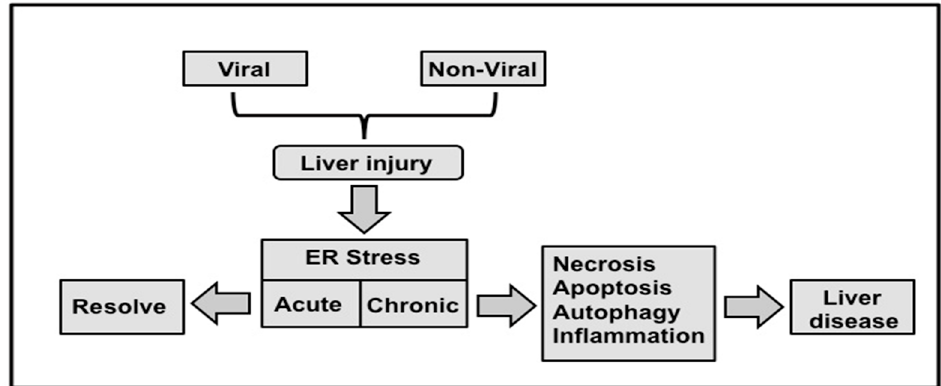
Figure 8. Diagram showing the relationship among ER ‐ stress, autophagy, and inflammation in the progression of liver disease induced by HCV infection. The ER ‐ stress can be tolerated from days to years through autophagy induction. Even if apoptotic cell death occurs, some extend due to the ER ‐ stress but the majority of cells survive due to autophagy during HCV infection. UPR can induce autophagy and inflammation, which contribute to liver disease progression.